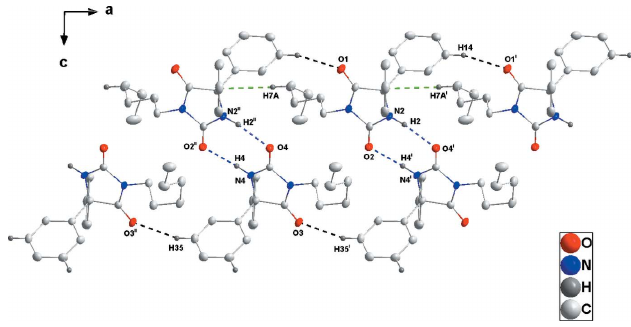
Figure 2 Detail of the chain-forming interactions. N—H (cid:3)(cid:3)(cid:3) O and C—H (cid:3)(cid:3)(cid:3) O hydrogen bonds are shown, respectively, as blue and black dashed lines. The C—H (cid:3)(cid:3)(cid:3) (cid:2) (ring) interactions are shown by green dashed lines [symmetry codes: (i) x + 1, y , z ; (ii) (cid:5) x + 1, y , z ; (iii) (cid:5) x + 1, (cid:5) y + 1, z ; (iv) (cid:5) x , (cid:5) y , (cid:5) z + 1].